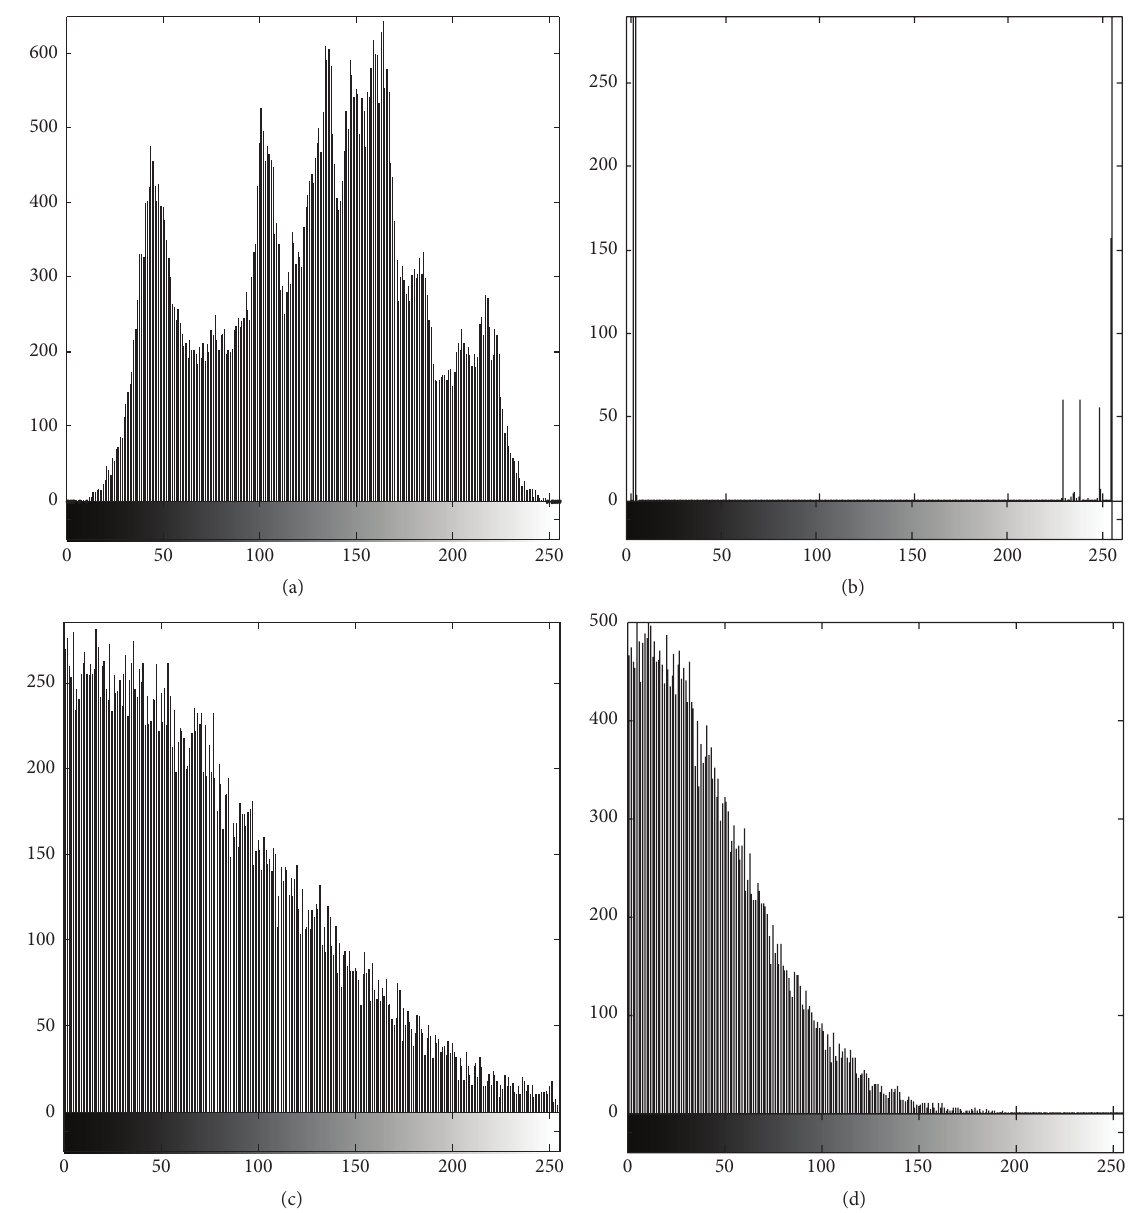
Figure 5: Histogram of (a) input image Lena, (b) input image OPT, (c) encrypted image Lena, and (d) encrypted image OPT.